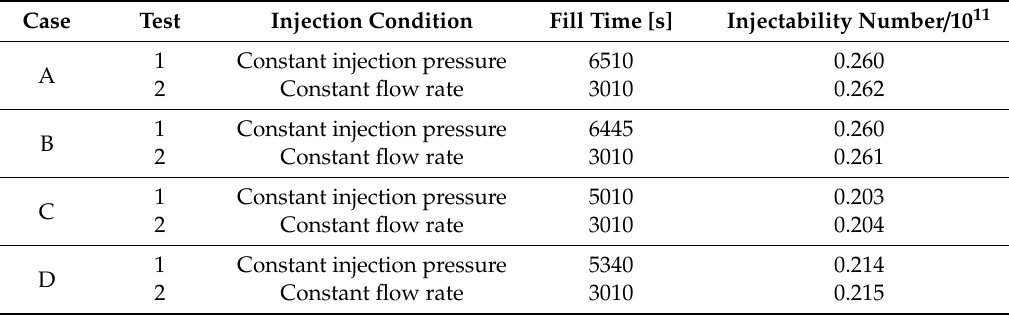
Table 10. Fill times and injectability numbers for filling cases of the fuselage